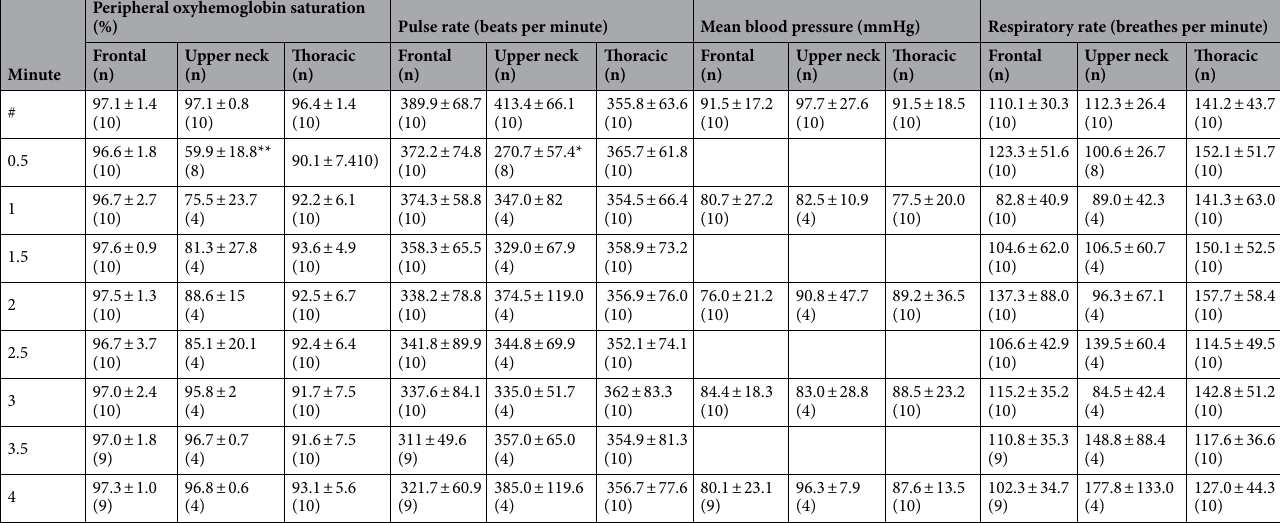
Table 2. Comparison of post-LISW vital signs. n: number of animals excluding dead animals in each group. ** p < 0.01, vs. Frontal and Thoracic groups. * p < 0.05, vs. Frontal and Thoracic groups. #: Immediately before LISW application.